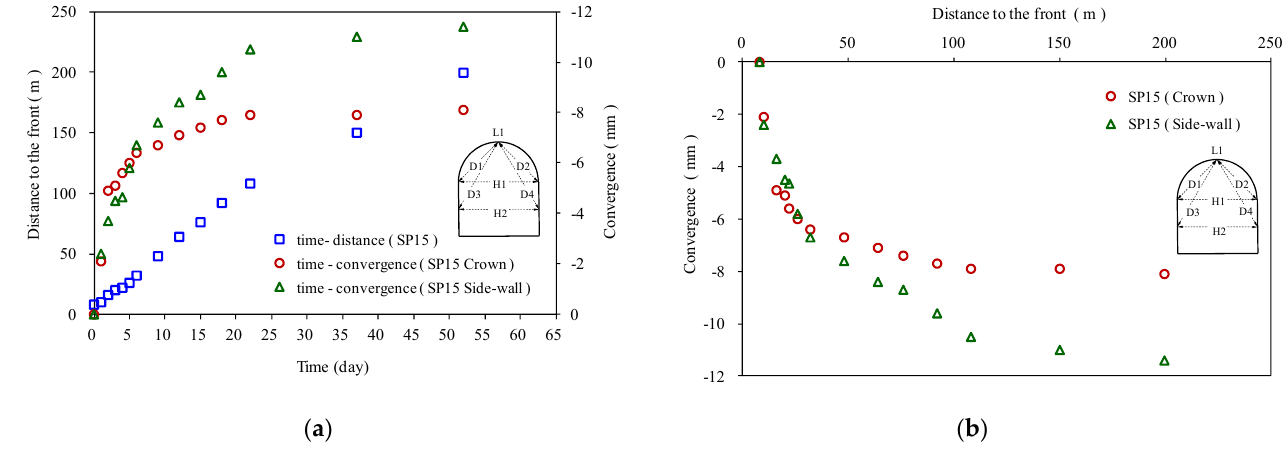
Figure 8. Filed measurements at the section of observation SP15 of the New Nanao tunnel ( a ) the information of time (day) of sequential construction, convergence (mm), and distance to the front (m), ( b ) relationship between convergence and distance to the front.